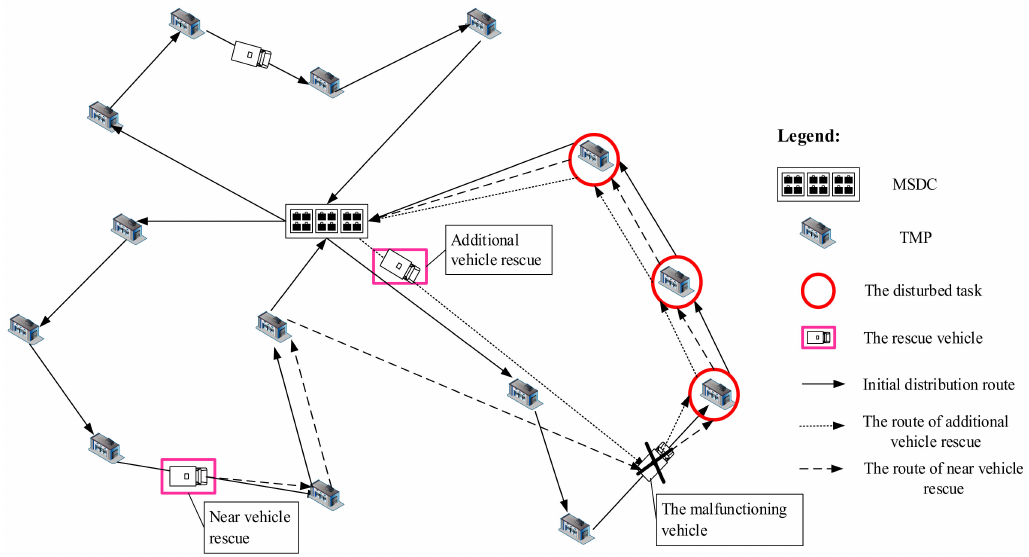
Figure 1. A schematic diagram of vehicle breakdown rescue.